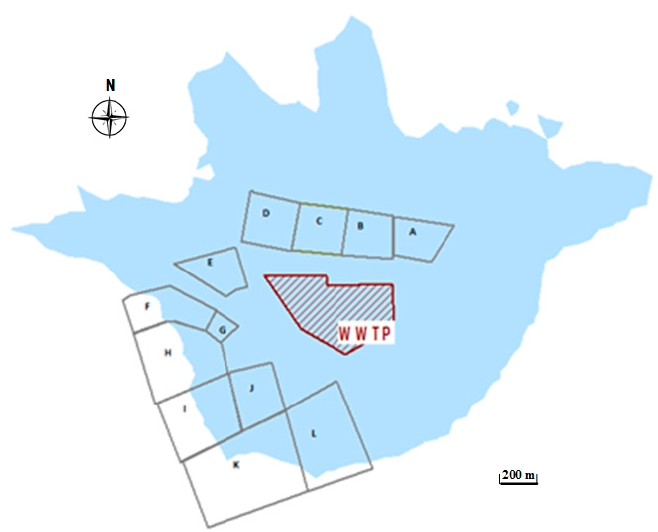
Figure 4. Direction-dependent separation distances based on the odor impact criterion (OIC) by air dispersion model. OIC: 4 ou/m 3 at the 99th percentile for the odor exposure calculated over the time period of nighttime of summer.